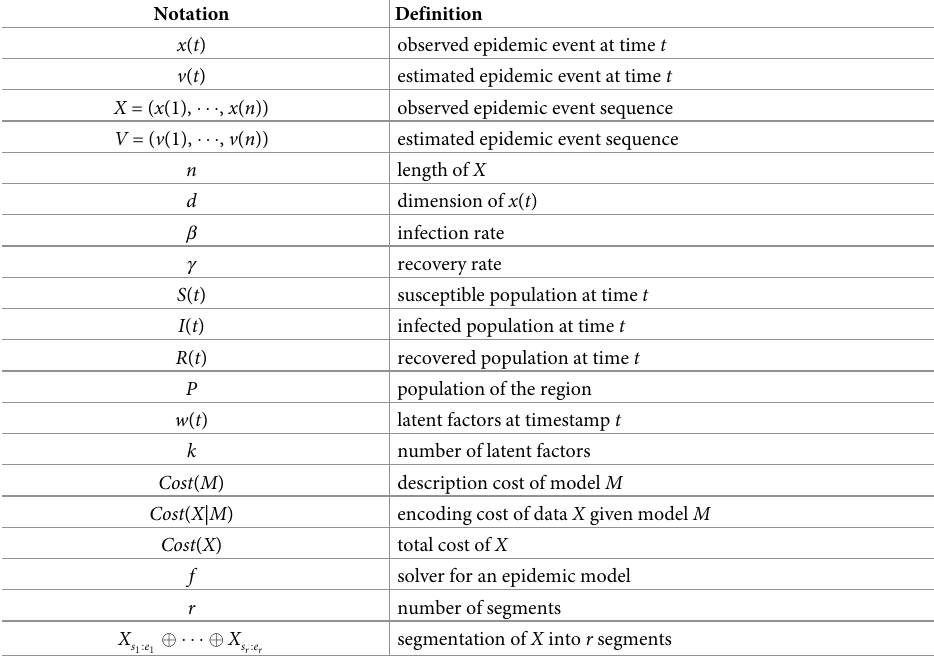
Table 1. Frequently-used notations and